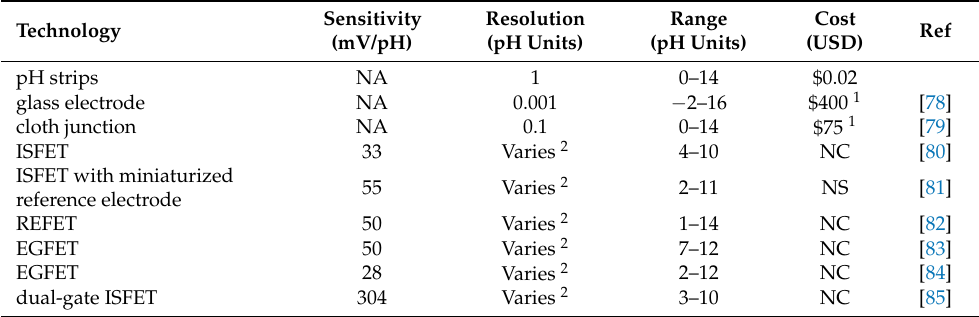
Table 6. Electrochemical Sensors for Measuring pH. NS: not specified; NC: not commercialized; NA: not